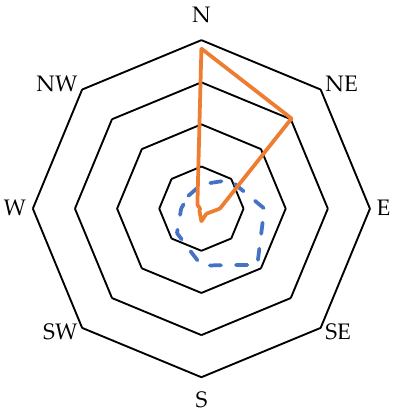
Figure 3. The overall and partial model of FLACS for shore-based bunkering operation for the hy- drogen powered ship. ( a ) The Overall FLACS model; ( b ) The partial FLACS model.